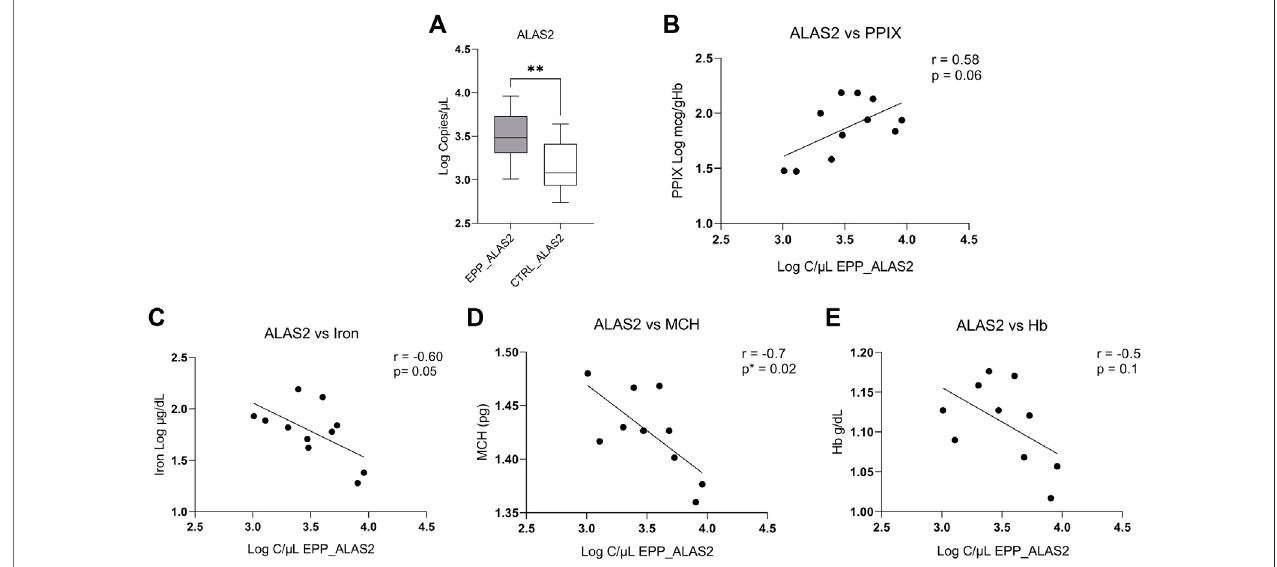
FIGURE 2 | (A) Highest EPP gene expression reported in Log of copies/µL for ALAS2 (B) Positive tendency between total PPIX level of patients and copies/ul of ALAS2. (C) Negative correlation between the iron level of patients and copies/ul of ALAS2. (D) Negative and signi fi cative correlation between ALAS2 quantity and MCH ( p * < 0.05; ** p ≤ 0.01). (E) Negative tendency between ALAS2 and